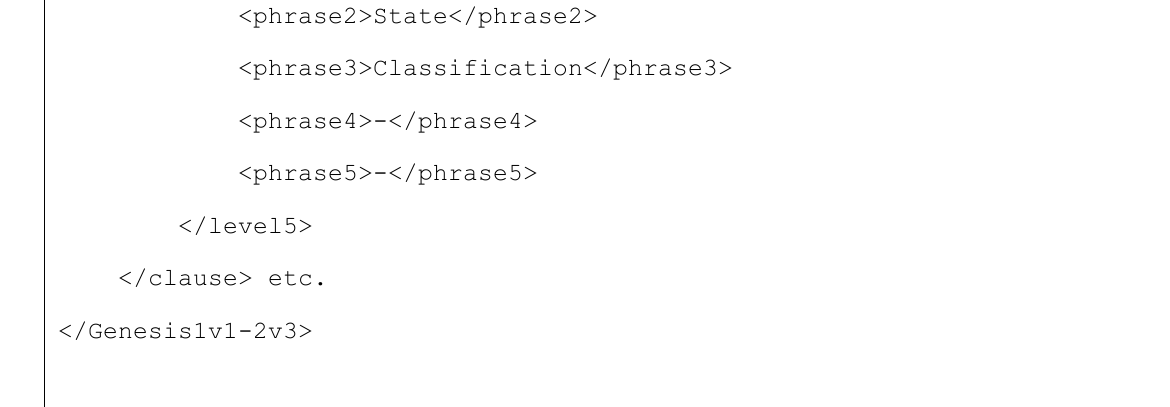
Figure 5. Two populated clause elements in the XML